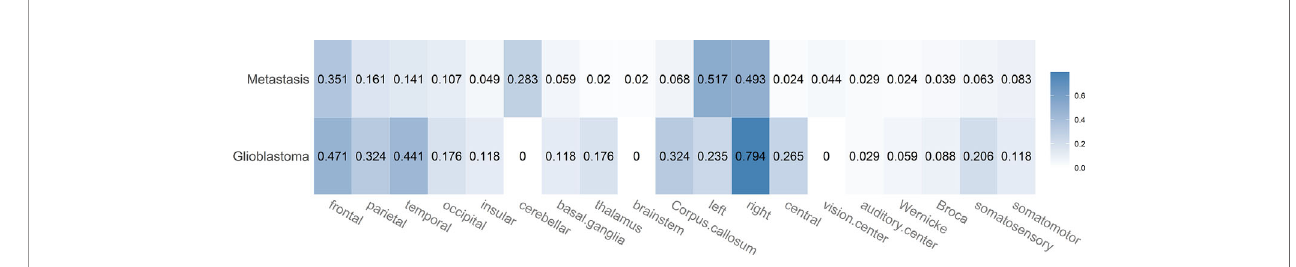
FIGURE 3 | Heatmap showing the proportions for the different localization-based MR features in case of brain metastases and glioblastoma. Each proportion corresponds to the ratio: number of lesions with feature/total number of lesions of that class. Darker color indicates a larger proportion.